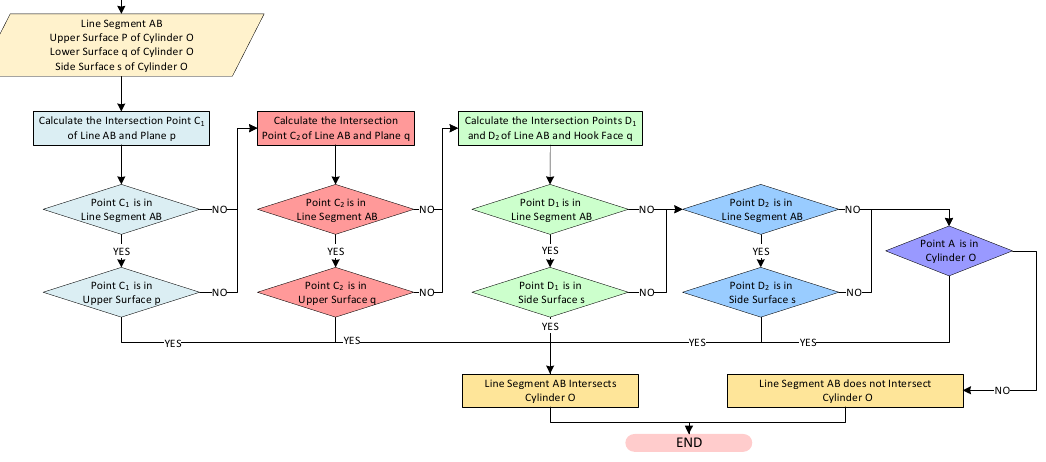
Figure 7. Application of the Intersection Detection Between a Line Segment and a Cylinder. First, whether the line where line segment AB is located intersects with the plane where the upper surface of the cylinder is located should be determined. If it intersects and the intersection point is in the line segment and the upper surface of the cylinder, then the line segment intersects with the